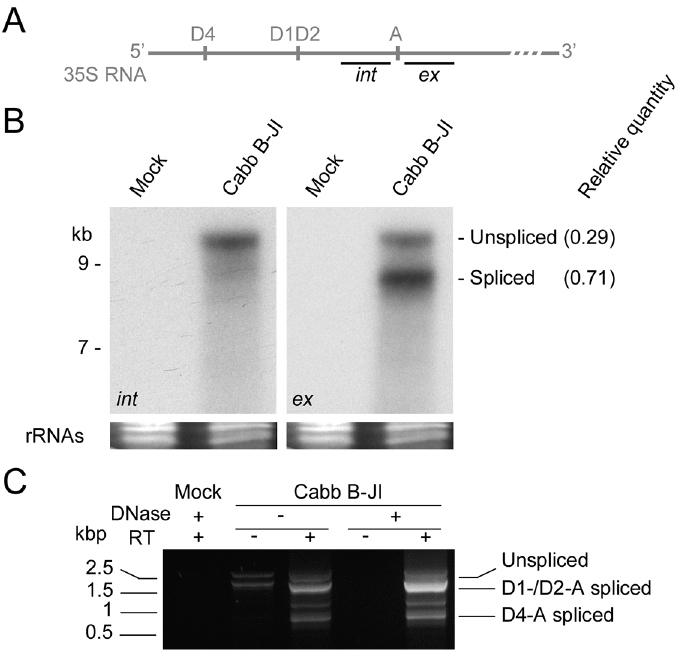
Fig 2. 35S RNA of CaMV Cabb B-JI isolate is alternatively spliced. (A) Oligonucleotide probes targeting the intronic ( int ) or the exonic ( ex ) region surrounding the acceptor site were used to detect 35S RNA and its putative spliced isoforms. (B) Northern-blotting analysis of turnip total RNA extracted at 21 dpi. RNA was separated by electrophoresis on an agarose (0.8%)-urea (7 M) gel, transferred onto a nylon membrane and probed with 32 P-labeled int or ex probes. Relative ratio between the unspliced 35S RNA and its spliced isoforms is indicated. (C) RT-PCR on turnip total RNA extracted at 21 dpi. The 5 ’ region of 35S RNA was amplified and the products separated on agarose